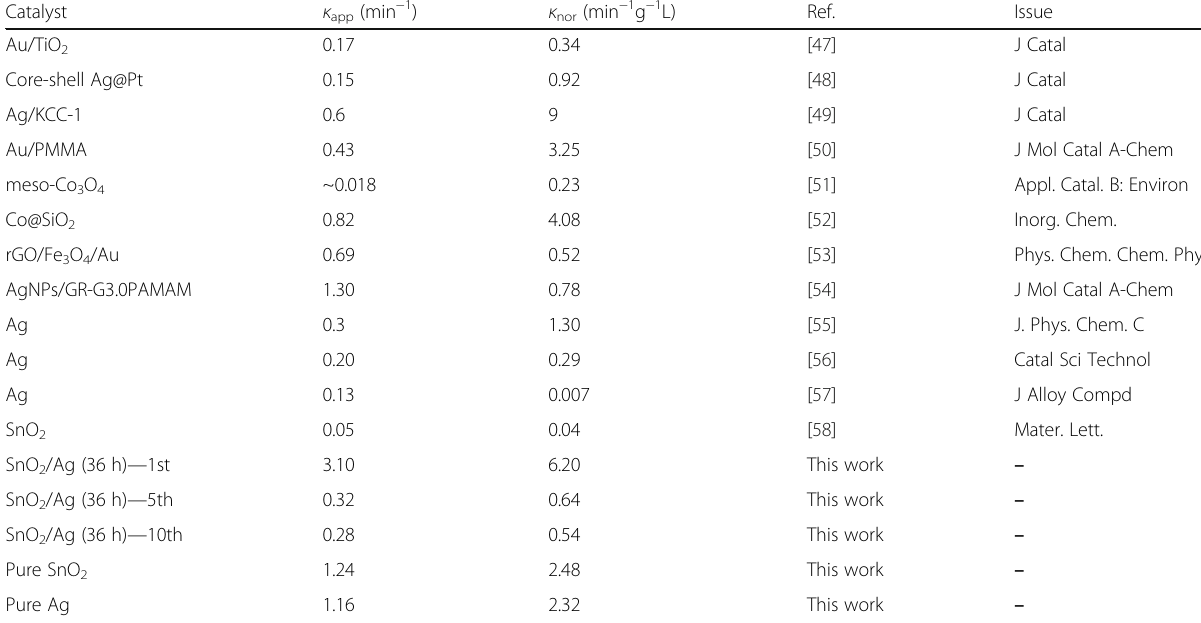
Table 2 Comparison of normalized rate ( κ nor ) of different catalysts for the reduction of 4-NP (at room temperature) Catalyst